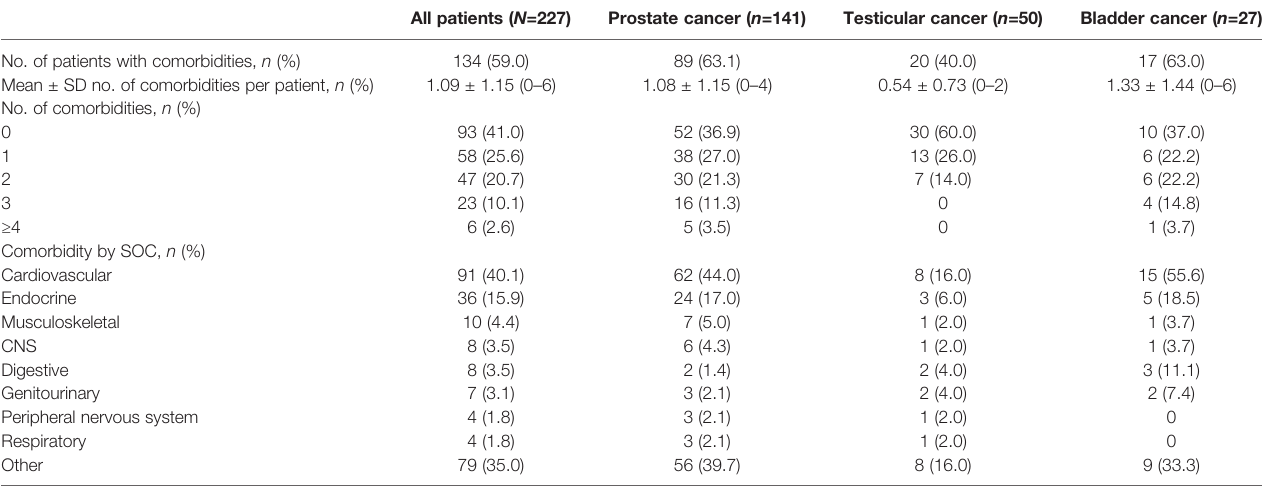
TABLE 2 | Comorbidities.